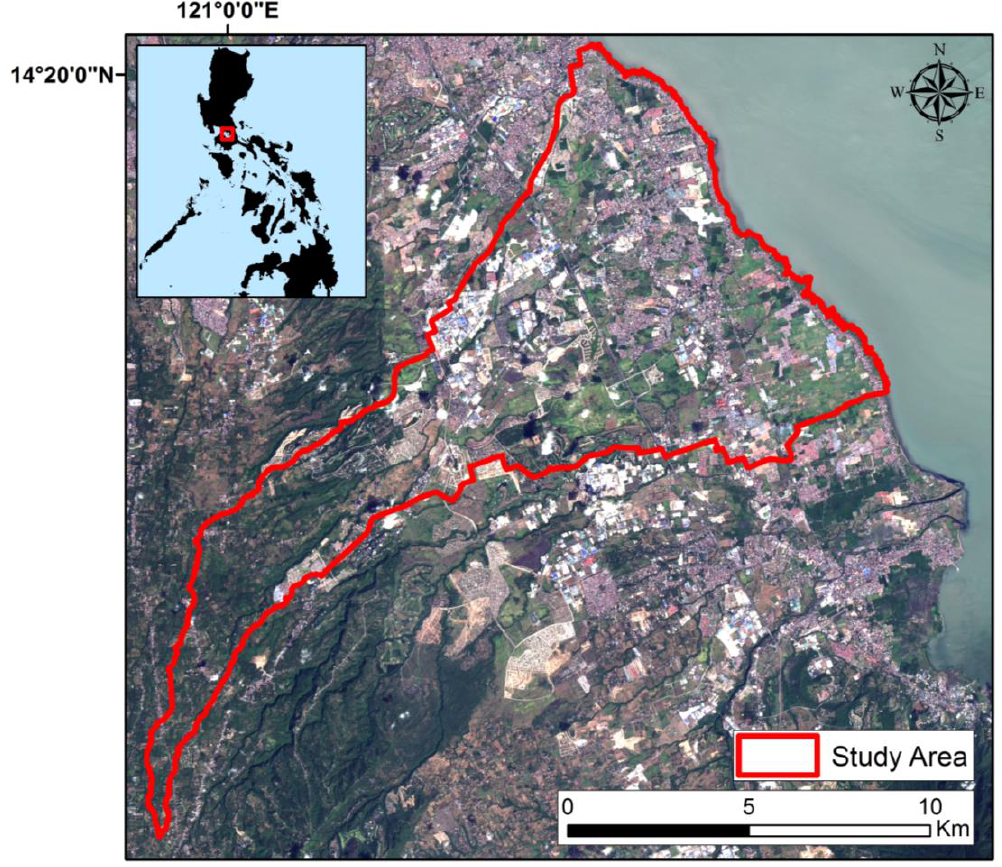
Figure 1. Overview of study area and Landsat 8 satellite imagery (natural color